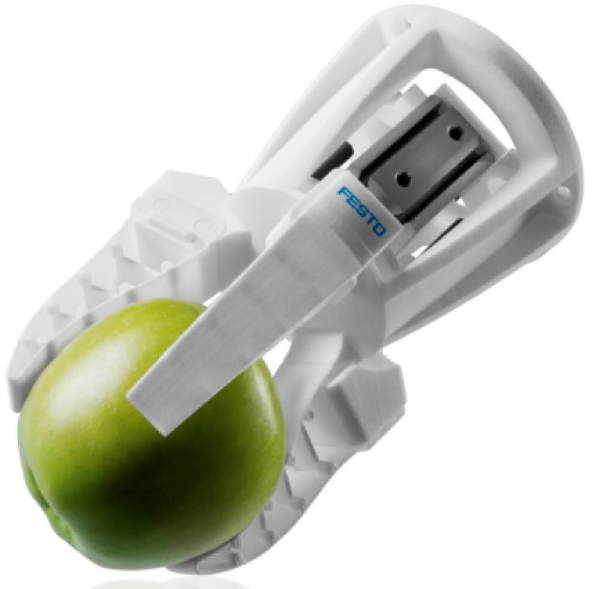
Fig. 3 Mechanical gripper with passive shape-adaptive elements [12]